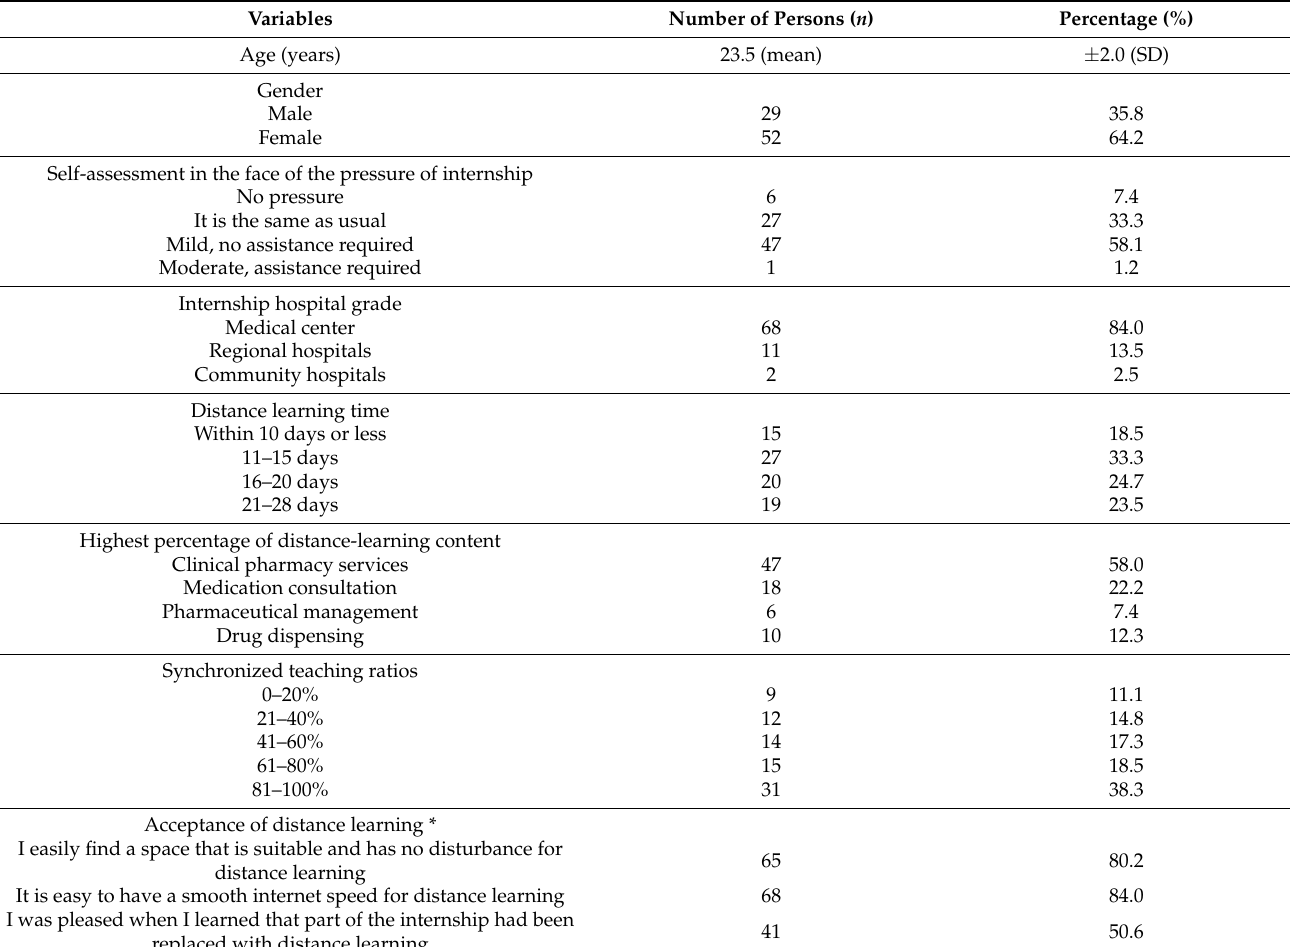
Table 1. Background information on the students who answered the